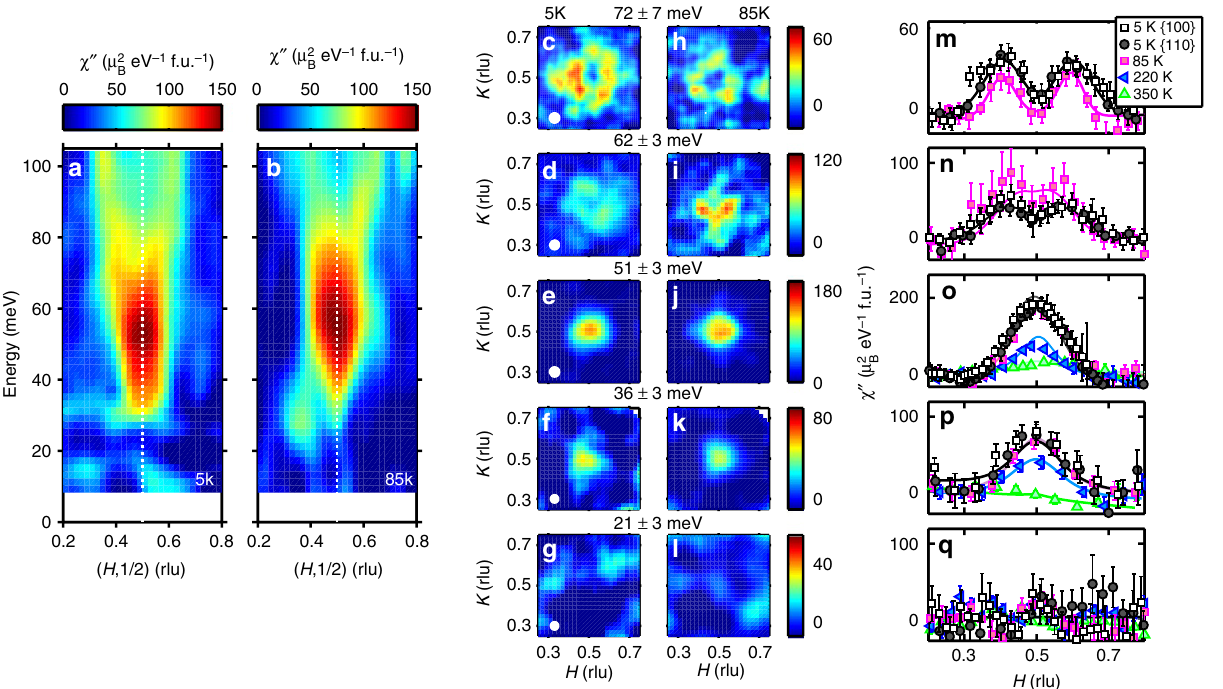
Figure 2 | Magnetic excitation spectrum of HgUD71 features gapped, commensurate and dispersive components. ( a , b ) Energy dependence of w 00 ( Q , o ) for HgUD71 at 5 and 85K (14K above T c ), respectively, along the two-dimensional momentum-transfer trajectory [ H ,0.5], with intensity averaged over the range K ¼ 0.5 ± 0.12. The gap D AF is defined as the energy below which no scattering is observed at q AF ; D AF E 27meV at both 5 and 85K. ( c – l ) Constant- energy slices of magnetic scattering at T ¼ 5K in c – g and T ¼ 85K in h – l . ( m – q ) The corresponding constant-energy cuts along high-symmetry trajectories. Cuts along {100} (average of [H00] and [0H0] cuts) and {110} (average of [HH0] and [H-H0] cuts) are shown for T ¼ 5 K (open black squares and closed black circles, respectively). Data at higher temperatures (85, 220 and 350K) are averages of four cuts along [H00], [0H0], [HH0] and [H-H0] trajectories. Error bars represent statistical error (1 s.d.). The white circles in c – g represent the momentum resolution at the corresponding energy transfers. Data collected on ARCS (see